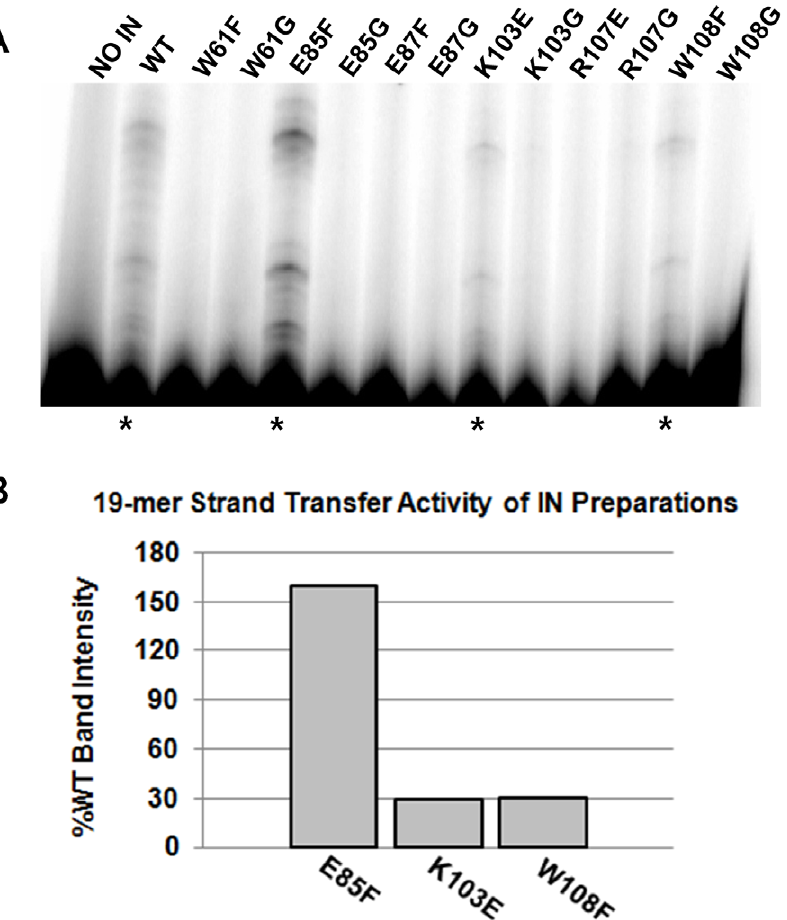
Figure 5. Pre-processed 19-mer DNA evokes mutant IN strand transfer activity. (A) The strand transfer activity of partly-purified mutant IN proteins with 19-mer pre-processed DNA substrate. (B) The activities of K103E and W108F are increased to about 30% of the WT levels in the presence of pre-processed 19-mer DNA substrate, while E85F is able to catalyze 160% of the WT level of integration (highlighted with an asterisk).